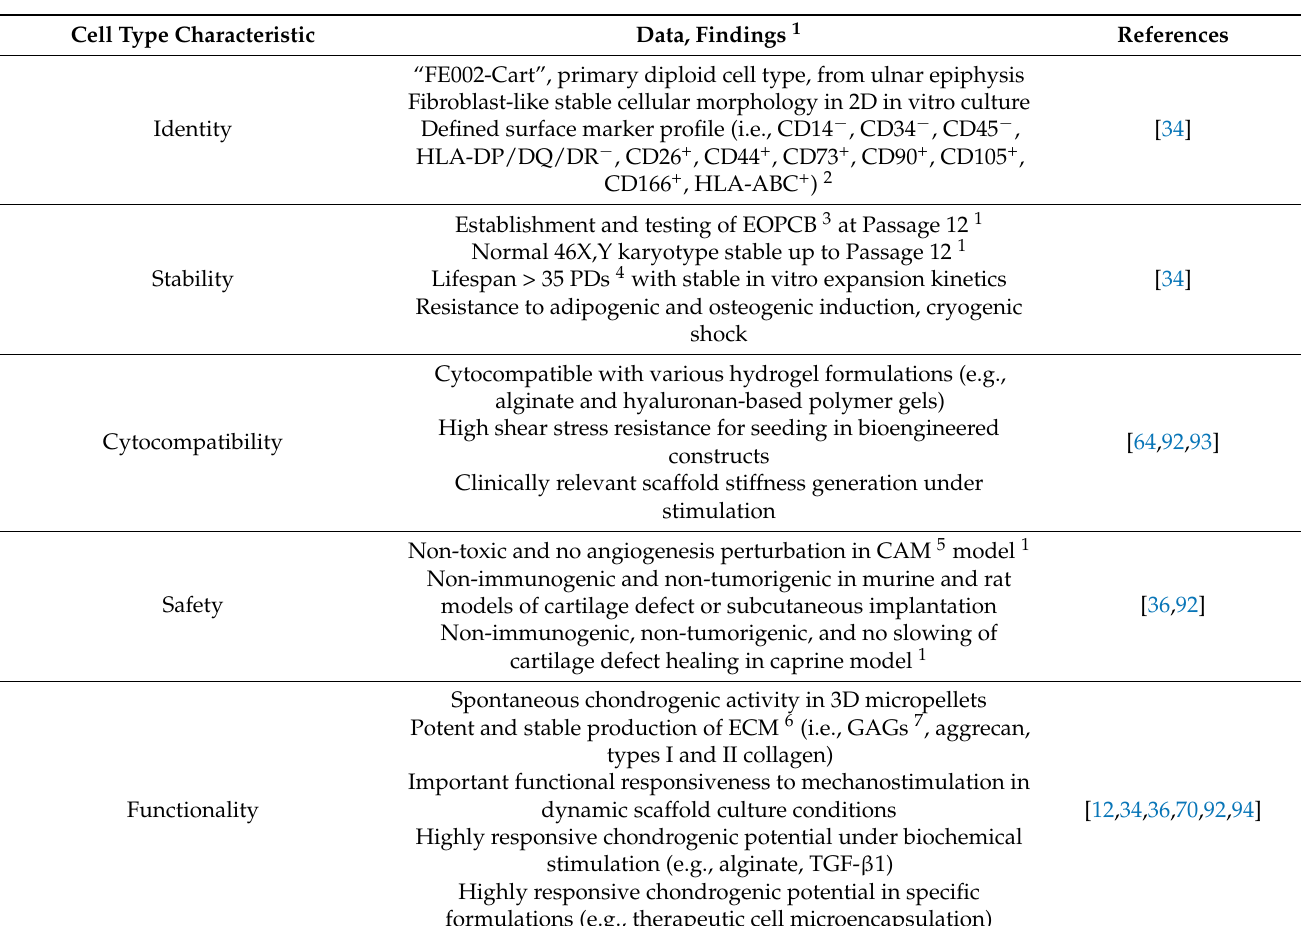
Table 2. FE002-Cart cell type characterization overview. Data succinctly comprise findings of our research group and those of collaborator groups working on the same primary cell source of